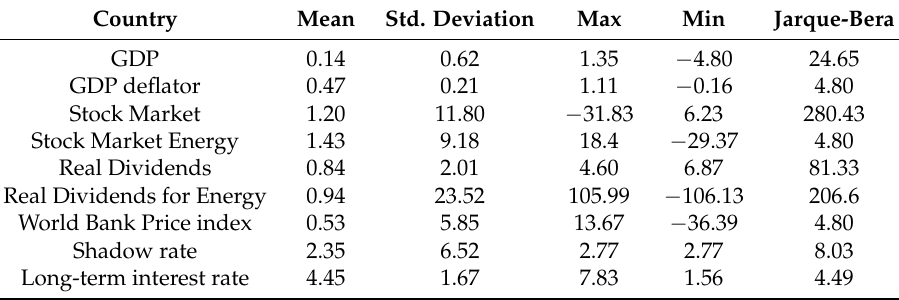
Table 1. Descriptive statistics.